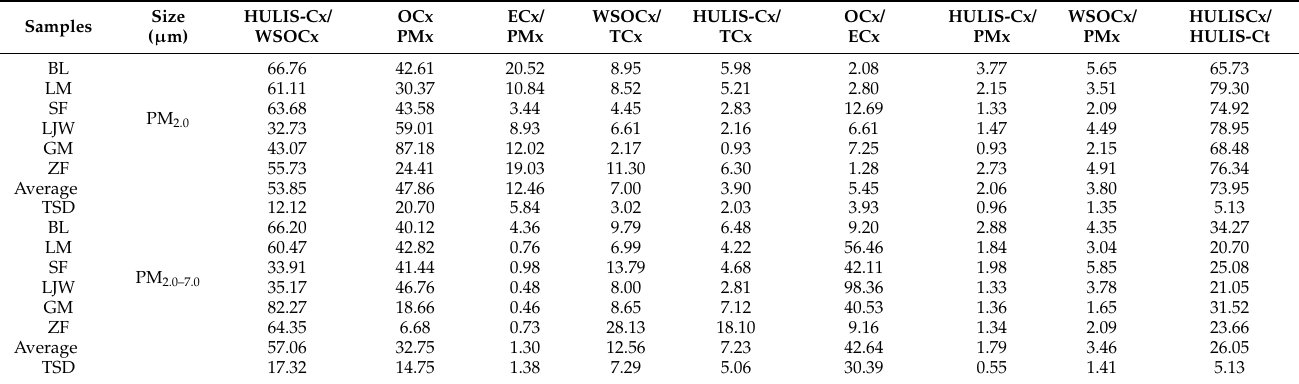
Table 6. The percentage of OCx, ECx, WSOCx to WSOC, and HULIS-C in PM 2.0 and PM 2.0~7.0 from RCC particles. Samples